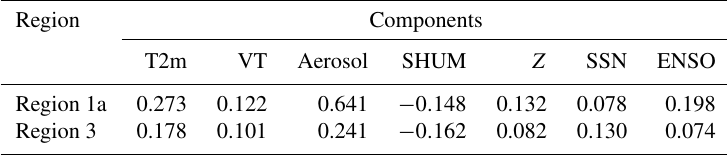
Table 3. MLR coefficients for aerosol components affecting DDF for region 1a, Lucknow and region 3. Region Components BC Dust OC Sea Salt Sulfate Region 1a 0.542 0.129 0.263 0.326 0.124 Lucknow 0.864